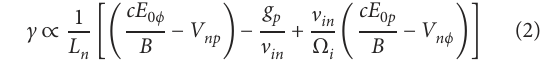
contours are shown as a function of longitude and altitude for equatorward winds (top: case 80eq) and for poleward winds (bottom: case 80po). The equatorward flow case, which